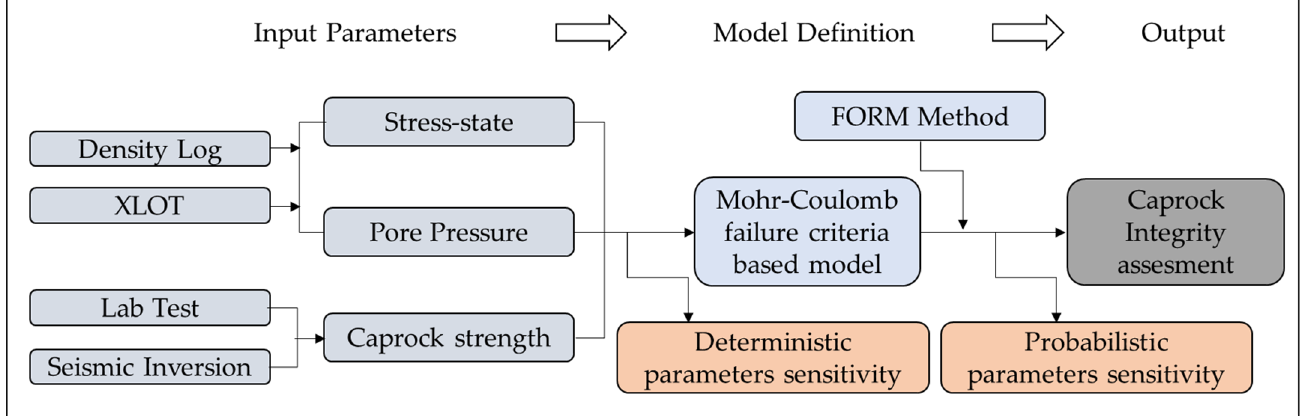
Figure 2. The workflow used in this study to assess the probabilistic structural reliability of Drake caprock shale as a top seal (XLOT—extended leak off test).